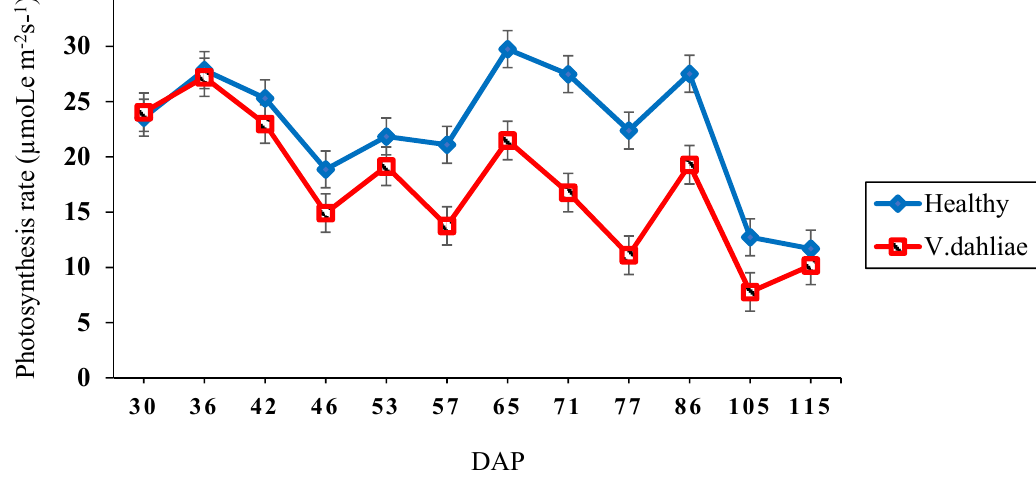
Figure 1. Photosynthesis rate over time of healthy and Verticillium dahliae inoculated greenhouse-grown upland cotton breeding lines (16-13-203V, 16-13-601V, 17-17-206V, and 17-17-606V) and cultivars (DP 1612 B2XF and FM 2484B2F), Each line graph represents the average photosynthesis rate for six genotypes, six replications, and three tests for healthy (blue) and V. dahliae treated (red) plants. The standard error bars shown for each